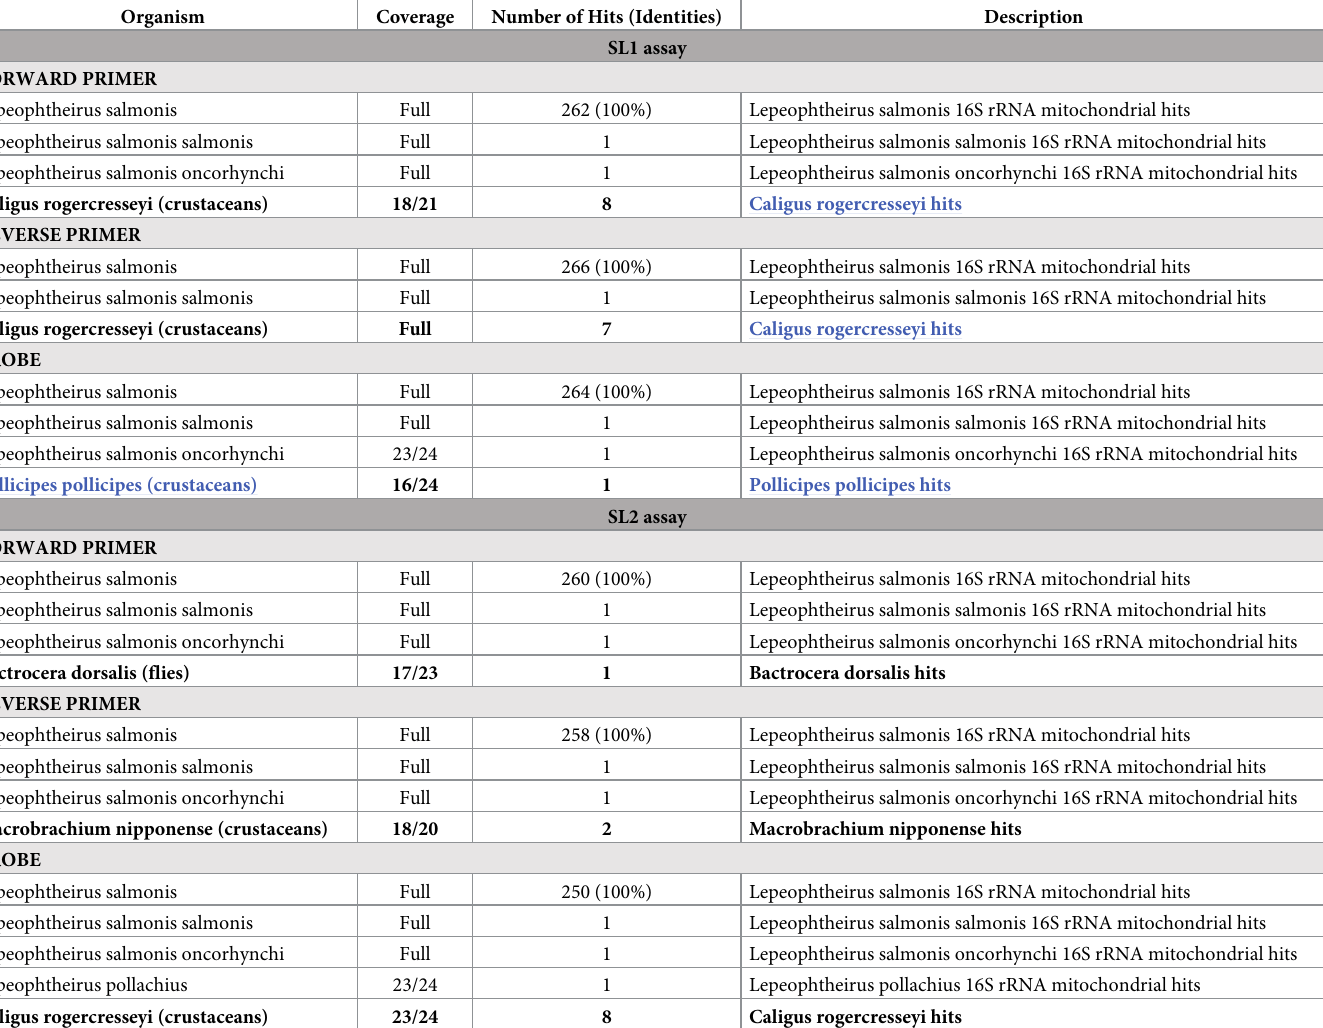
Table 1. SL2 and SL1 primers and probes specificity characteristics based on the in-silico evaluation using blastn. The table includes Lepeophtheirus BLAST hits and the best non- Lepeophtheirus hits (on